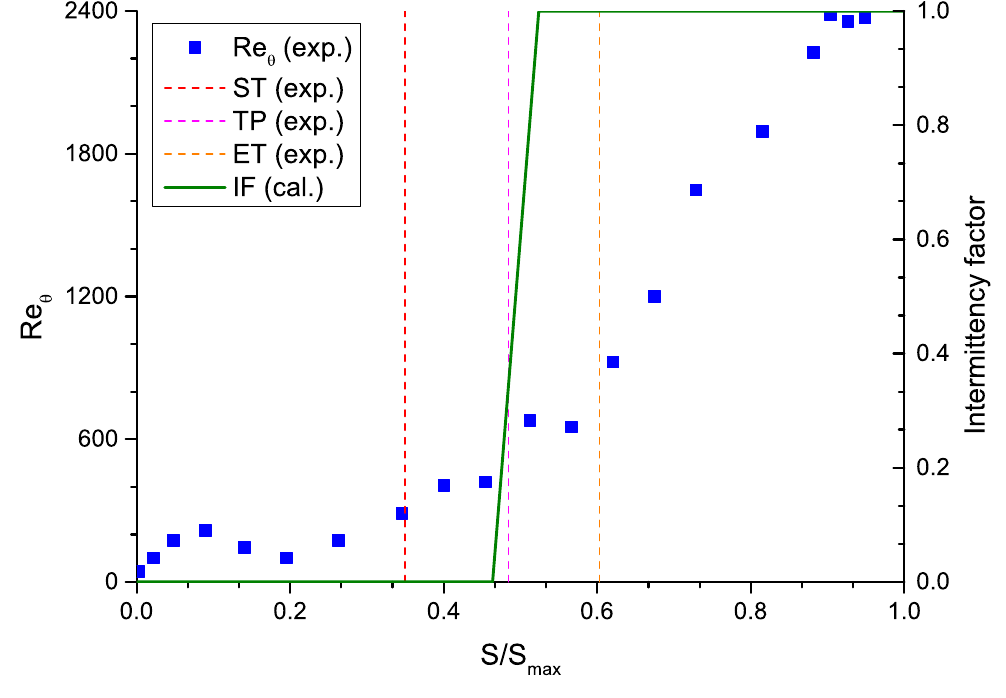
Figure 6. The validation of transition position prediction. The scatters represent the Re θ distribution obtained from Ubaldi’s experiment [51]. The solid line represents the calculated intermittency factor distribution by computational fluid dynamics in this paper.